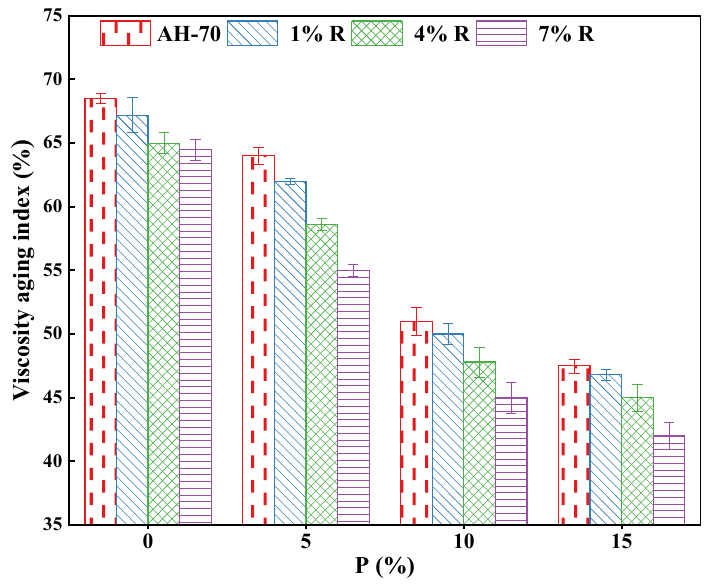
Figure 9. Viscosity aging index.